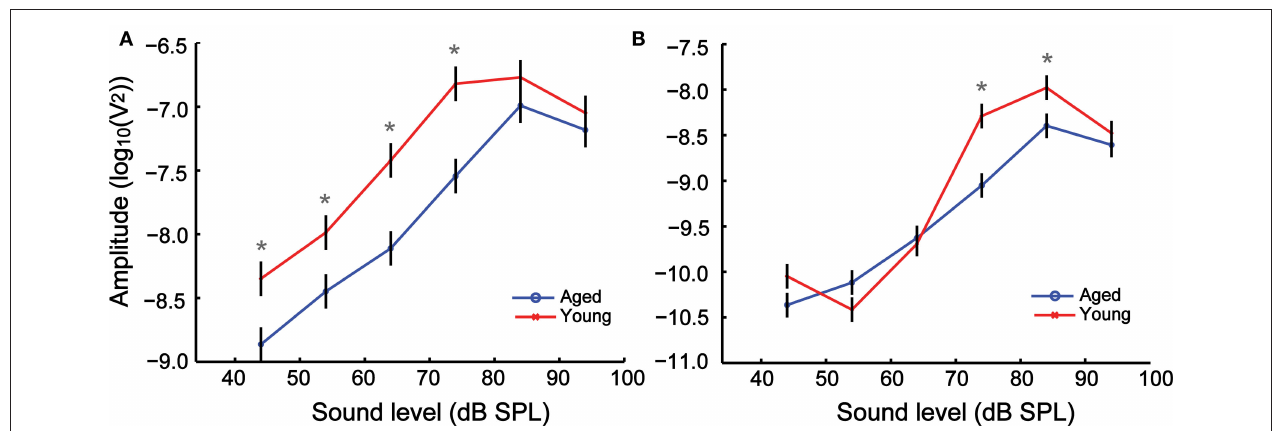
level of the AM stimuli is represented along the x axis, and the LSM ± SE of the FFT amplitudes along the y axis. Asterisks indicate statistically significant difference in LSMs ( P < 0.05,